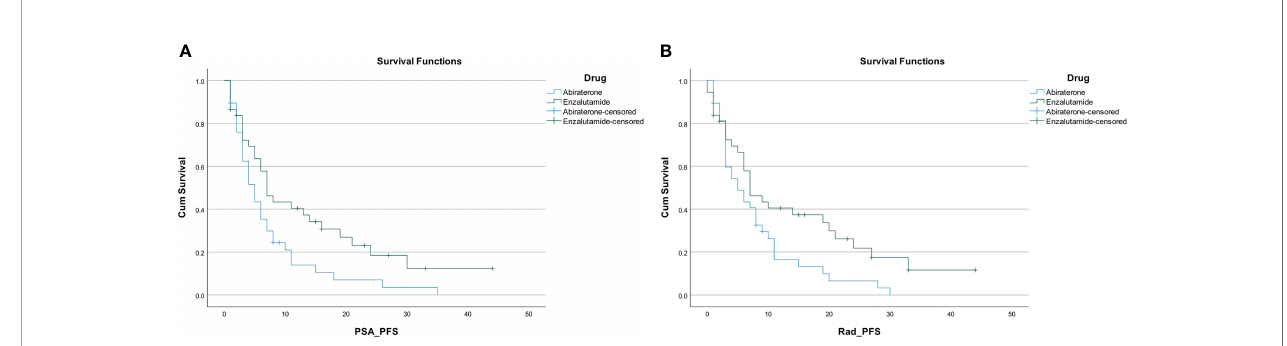
FIGURE 2 | (A) PSA progression free survival. (B) Radiographic progression free survival.